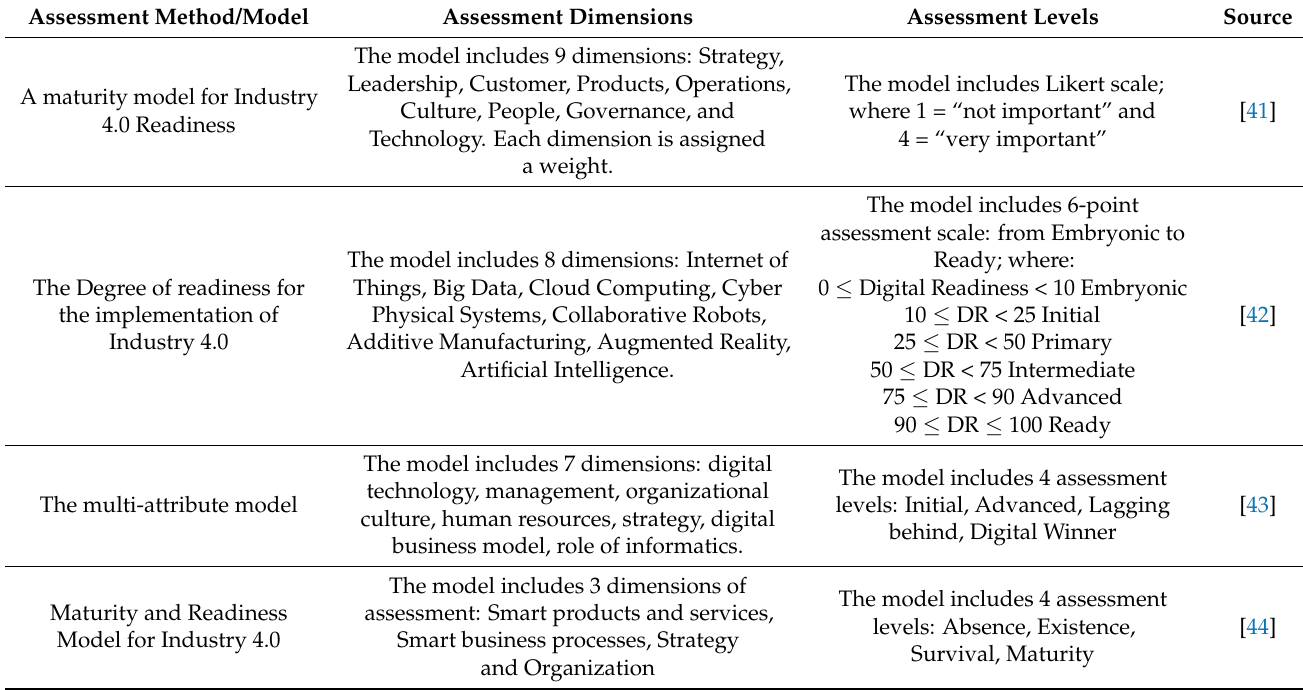
Table 1. Characteristics of methods/models for assessing the level of readiness or digital maturity of